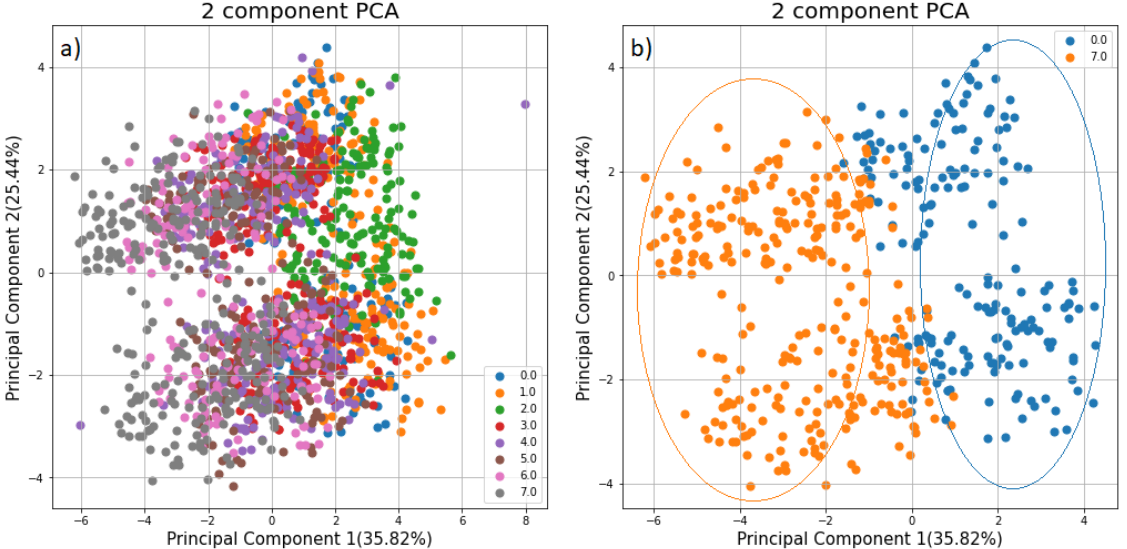
Figure 5. Two Components PCA model: ( a ) PCA applied to all samples. ( b ) PCA applied only to sample WaterPvP0 and WaterPvP7.